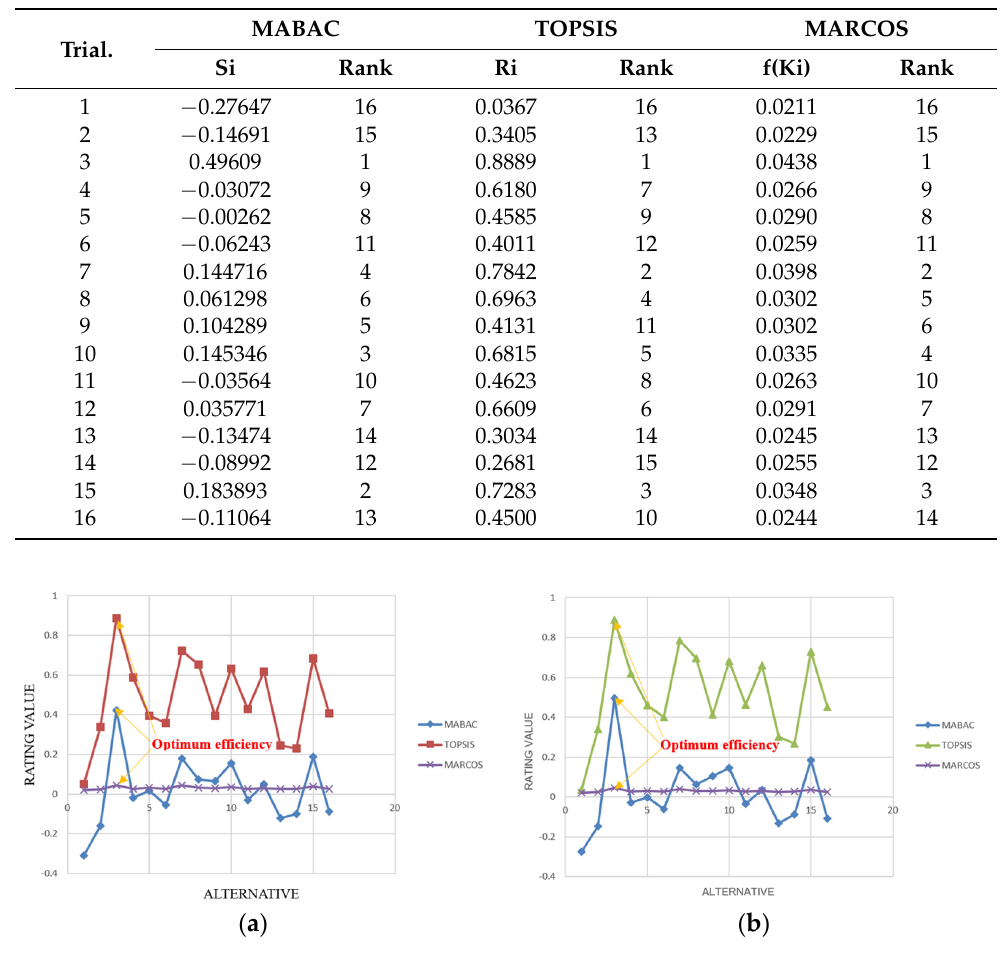
Table 7. Priority index and ranking when the weight calculation by MEREC method. Trial.